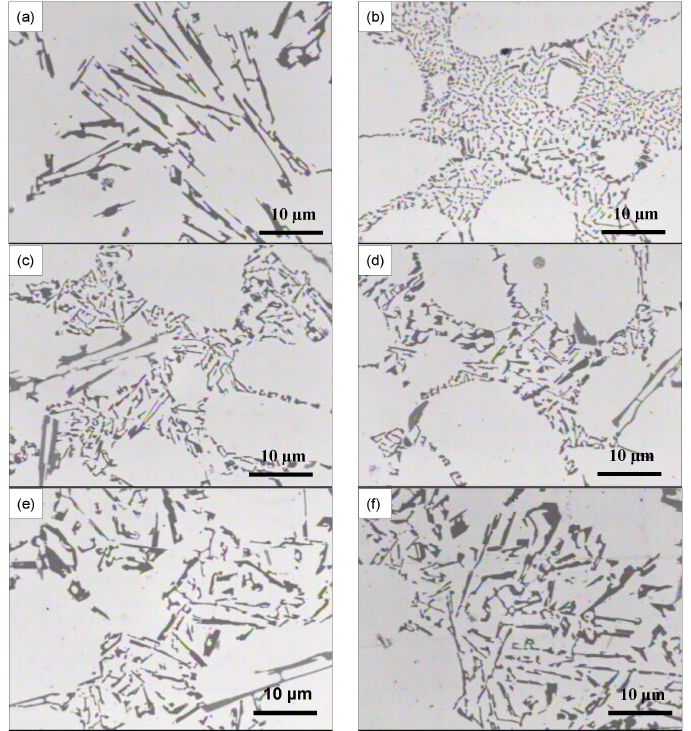
Figure 6. Microstructures of different A356-based alloys: ( a ) base TB alloy (non-modified); ( b ) TBS alloy (0.01% Sr); ( c ) T10 alloy (0.2% La); ( d ) T11 alloy (0.2% Ce); ( e ) T2 alloy (1% La); and ( f ) T5 alloy (1%